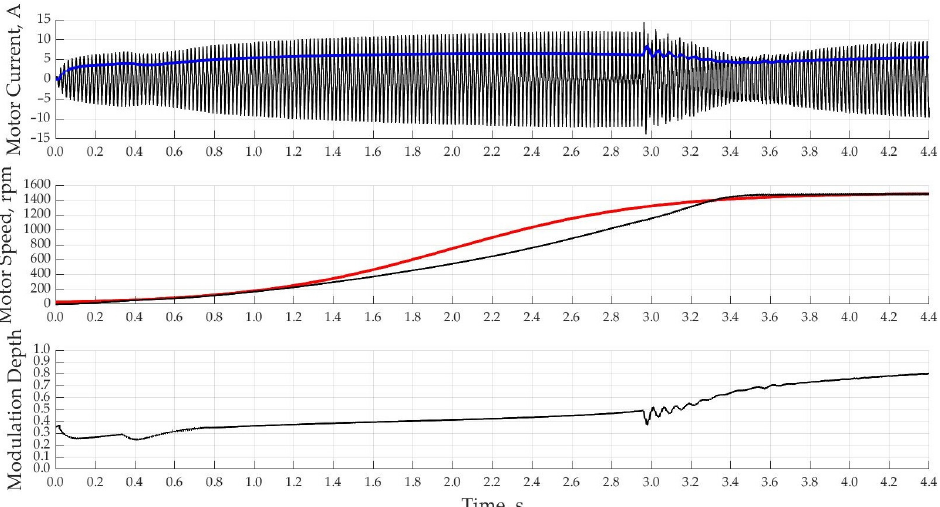
Figure 19. Starting current, motor speed and modulation depth for case of PI-controller with double- loop CS of IM current and speed with sigmoidal increase in speed by reference and smoothly loaded shaft.